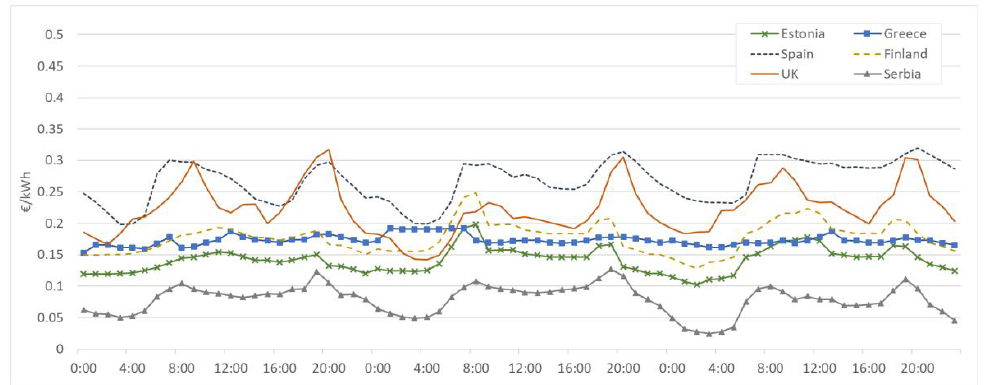
Figure 1. Obtained electricity retail prices from 01/10/2018 to 04/10/2018 for each country. In Figure 1 it can be observed the variety on the electric kWh per country, where Spain is paying approximately double than Estonia and triple than Serbia.